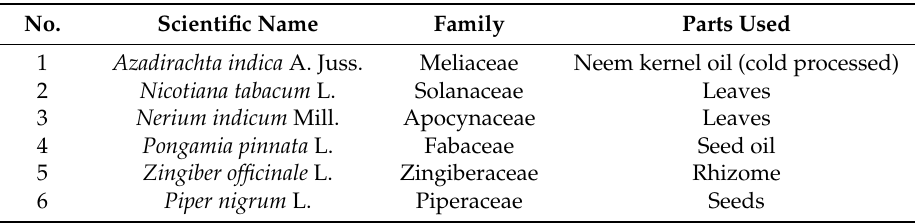
Table 1. Plant materials evaluated for molluscicidal